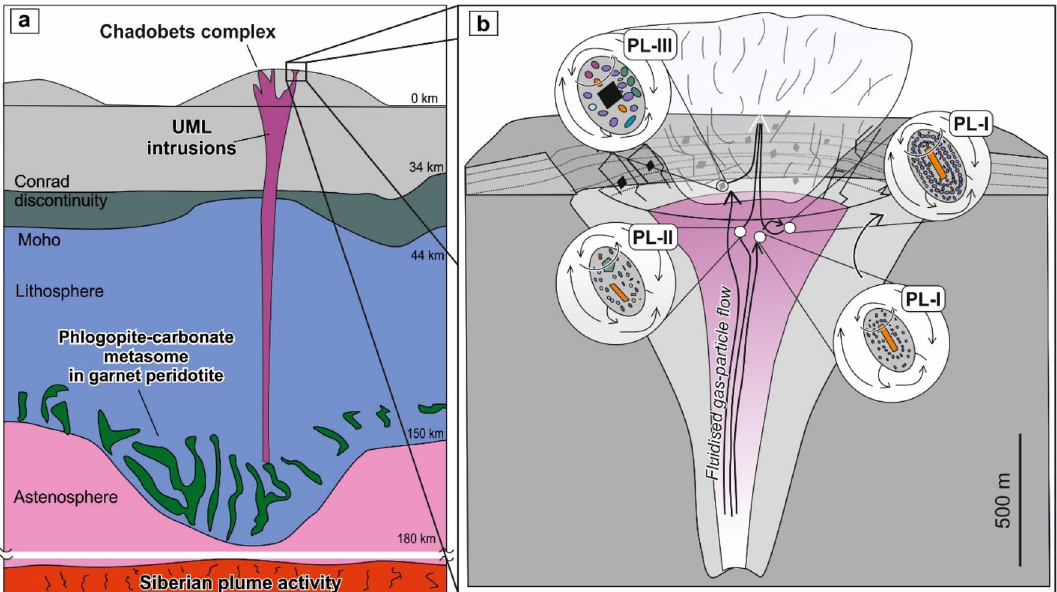
Figure 6. Schematic model showing the origin of the Chadobets complex UMLs from a carbonate-rich mantle source ( a ) and pelletal lapilli in damtjernites ( b ) (after 7,25 ). The pelletal lapilli-I (PL-I) have a well-developed zoning, most likely formed under deep conditions in an early stage; their structure and texture evidence multiple coating of juvenile melt droplets. The pelletal lapilli-II (PL-II) presumably assembled at depths similar to the first type of pelletal lapilli or even deeper, owing to the dimension of minerals in the pelletal lapilli-II. The composition of the outer zone in the pelletal lapilli-III (PL-III), as well as the size of minerals and the composition of kernels itself (sedimentary xenoliths) indicate their near-surface origin. The figure was created using Corel Draw X4 software https:// www. corel draw. com/ en/ pages/ corel draw-